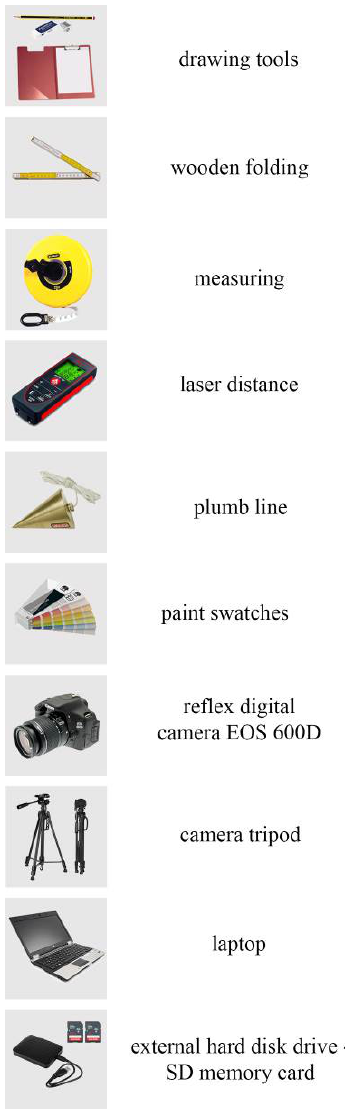
Figure 2. Tools used for the survey